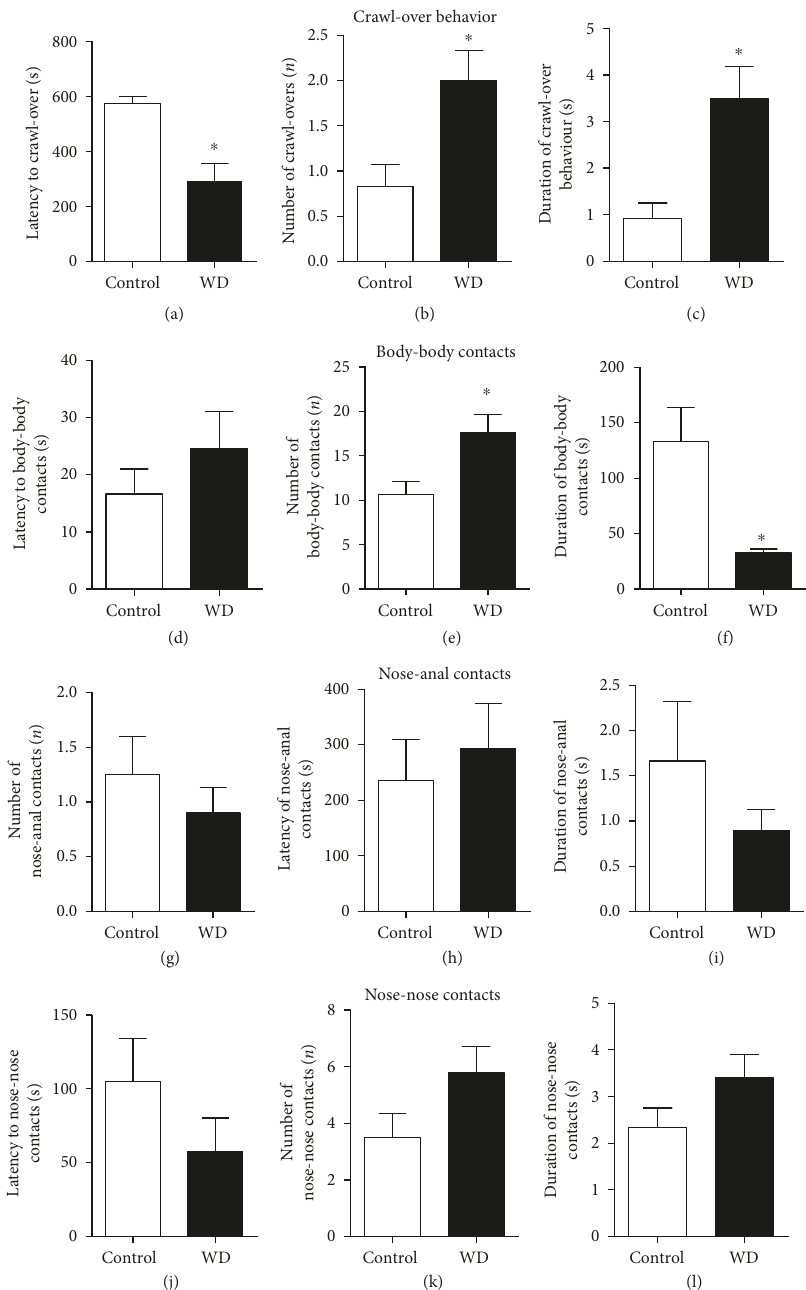
Figure 3: The high-cholesterol diet potentiates dominant-like behaviour and suppresses sociability in a food competition test. In comparison to the control group, mice housed on the high-cholesterol diet showed (a) a signi fi cant decrease in the latency to crawl-over behaviour and (b) a signi fi cant increase in a number of crawl-overs, as well as (c) prolonged total duration of crawl-over behaviour ( ∗ p < 0 05 versus that in the control group; Mann-Whitney test). In comparison to the control group, mice exposed to the cholesterol-enriched diet had (d) no signi fi cant changes in the latency to body-body contacts and had (e) a signi fi cant increase in a number of body-body contacts ( ∗ p < 0 05 versus that in the control group; Mann-Whitney test) and (f) a signi fi cant decrease in the duration of body-body contacts ( ∗ p < 0 05 versus that in the control group; Mann-Whitney test). No signi fi cant group di ff erences were observed between the groups in the parameters of nose-anal contacts: (g) the number of nose-anal contacts, (h) latency to nose-anal contacts, and (i) total duration of nose-anal contacts ( ∗ p > 0 05 versus that in the control group; Mann-Whitney test). There were no signi fi cant group di ff erences in the parameters of nose-nose contacts: (j) latency of nose- nose contacts, (k) number of nose-nose contacts, and (l) total duration of nose-nose contacts ( ∗ p > 0 05 versus that in the control group; Mann-Whitney test). Control — standard diet, WD — high-cholesterol diet. Data are shown as mean ±